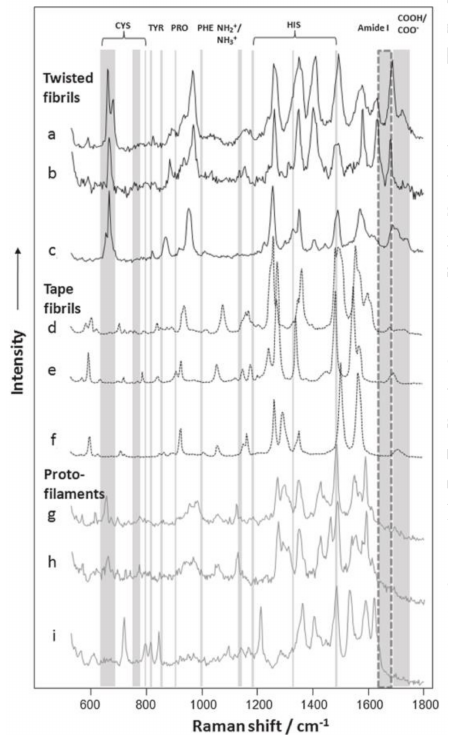
Figure 5. Selected TERS spectra acquired from the surfaces of insulin fibril polymorphs and their protofilaments. TERS spectra collected from the surfaces of twisted are shown in a–c and d–f are the Raman signals of flat fibrils, g–i are the TERS spectra collected from the surfaces of their protofilaments. Specific amino acid vibrational modes are marked with gray lines. Amide I bands are marked with dashed lines, showing the borders between protein secondary structures. NH2/NH3 (1144 cm − 1 ) and COOH/COO—(1687–1700 cm − 1 ) vibrational modes are also indicated. Reprinted with permission from ref. [25]. Copyright 2014, the Biophysical